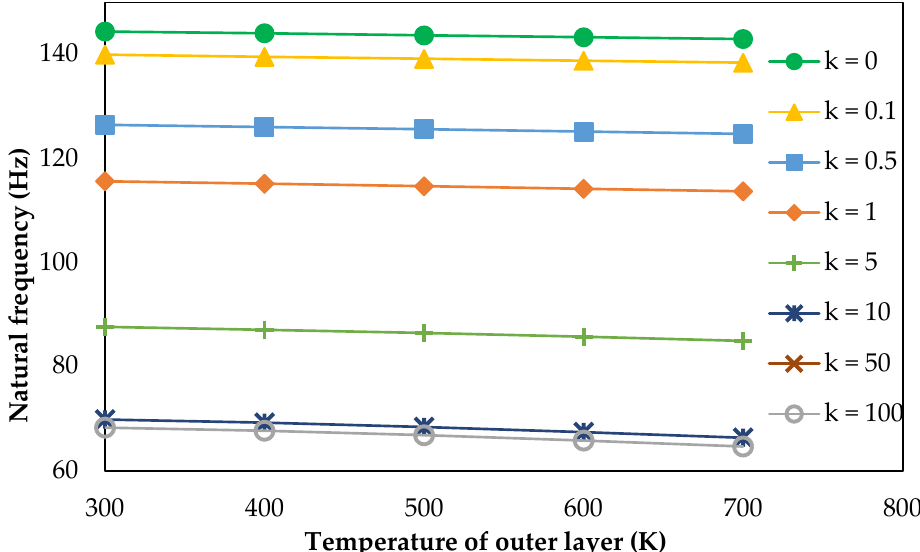
Figure 11. Variation of the natural frequency of an aluminum/silicon carbide FGM shell under a linear temperature rise for different material composition for re-entry vehicle nose structures.